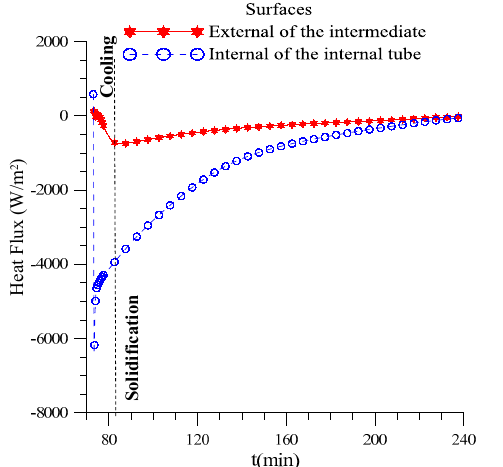
Figure 28. Heat flux for the external surface of the intermediate tube and the internal surface of the internal tube throughout the solidification process.